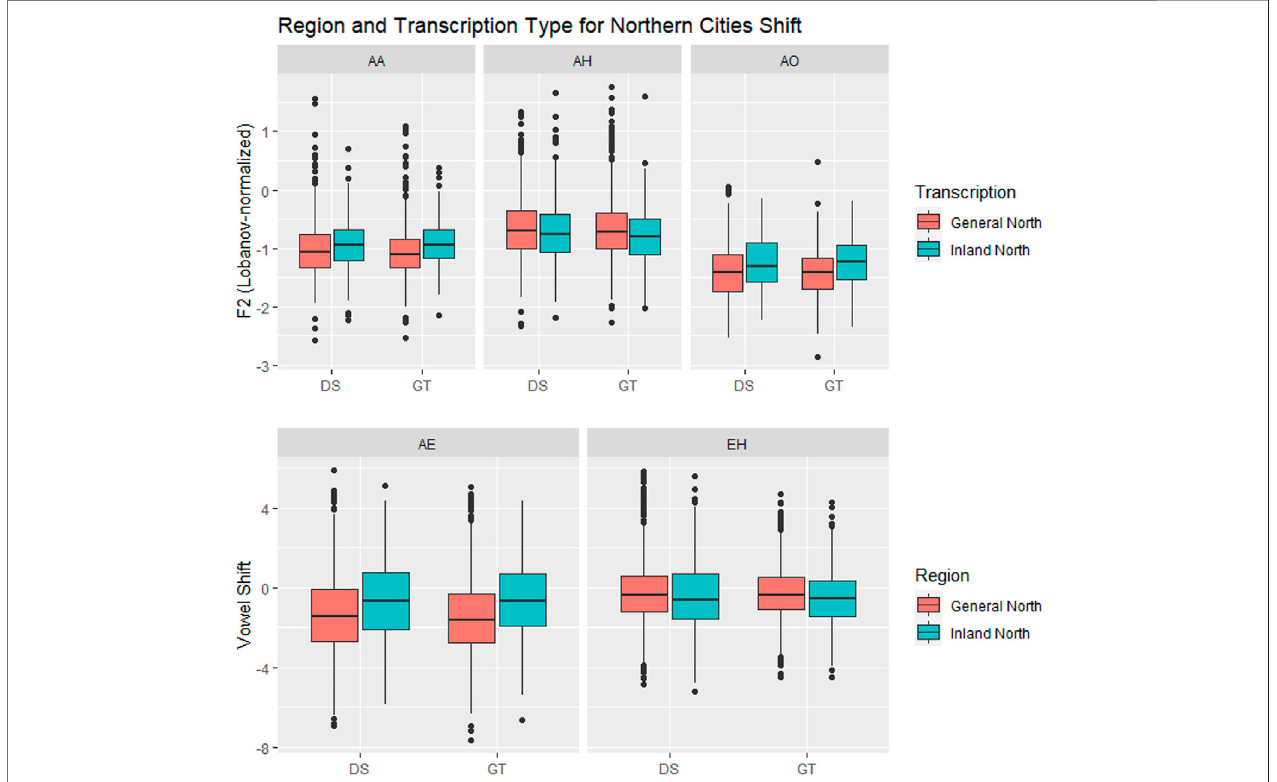
FIGURE11| Vowelsin theNorthern CitiesShift,byRegion (General North versusInland North)and transcriptiontype. In threeofthevowels(AE, AA, AO)there are signi fi cant differences between General North and Inland North